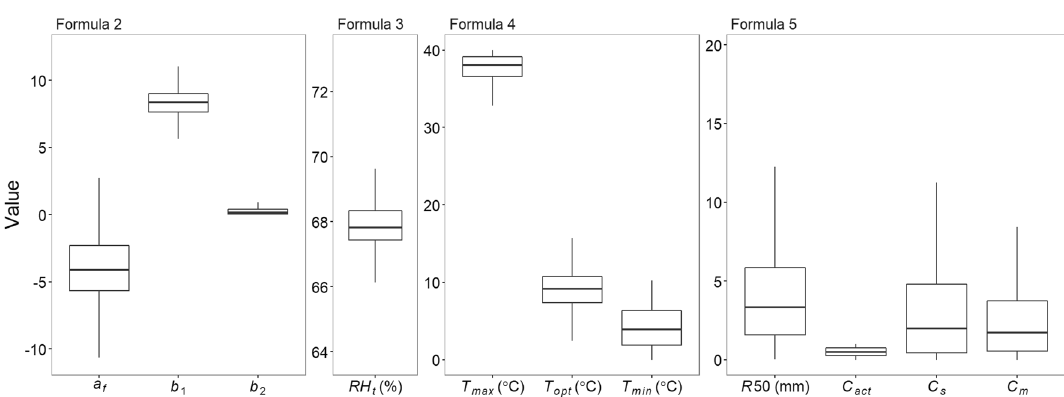
Figure 2. Bayesian estimation of the model parameters and their posterior distributions in the best model without considering the difference between conventional (CF) and low-external-input farming (LF) (based on the same value of the constant baseline a f for different farming systems in Formula (2)) among the two competing models. The other model considers the difference based on two different values of constant baseline a f